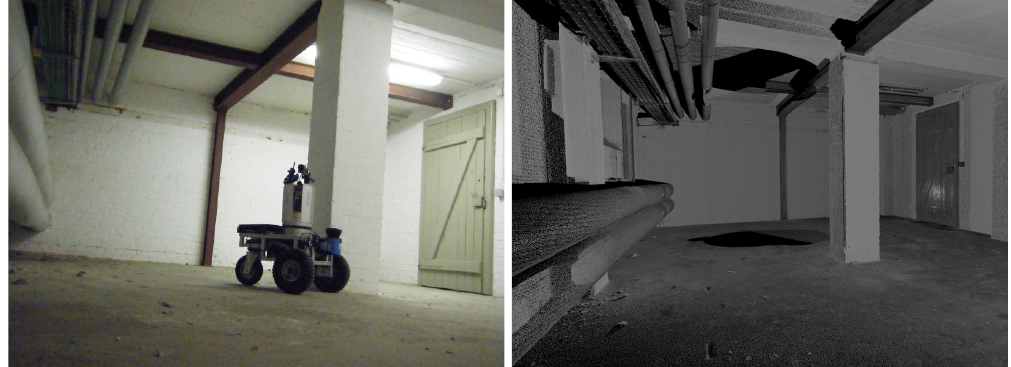
( Left ) The robot Irma3D in the room where the experiments were carried out. ( Right ) The model of the basement (colored by reflectance) as acquired by standard terrestrial laser